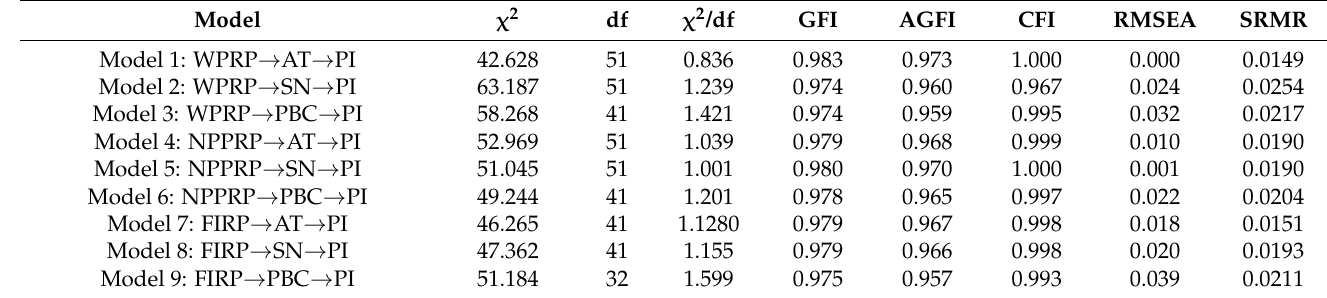
Table 6. Model fit indices.